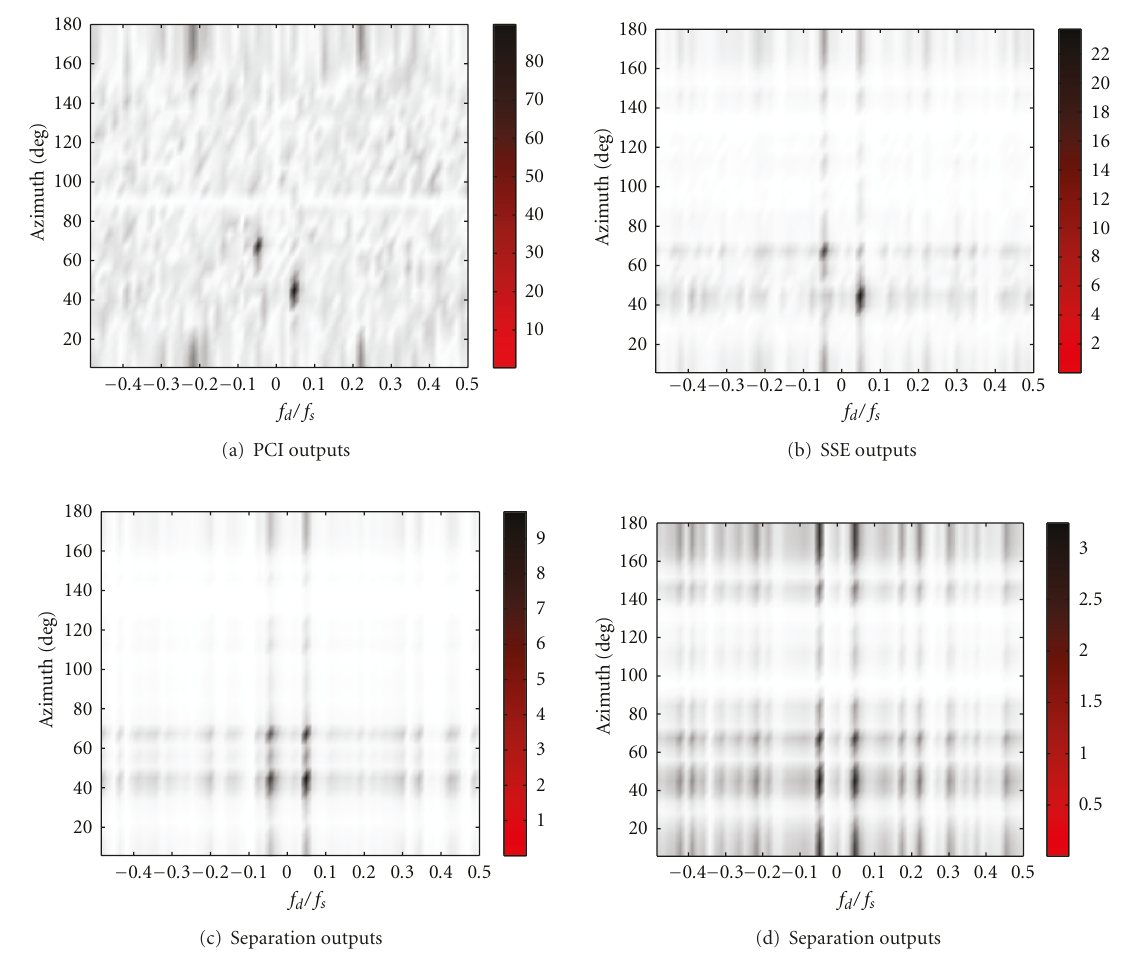
Figure 8: PCI, SSE, and separation via SSE with conventional matrix.